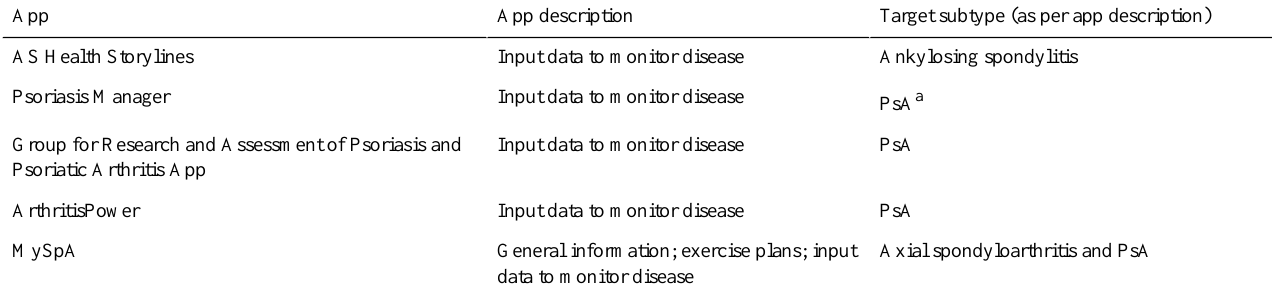
Table 3. App description and target